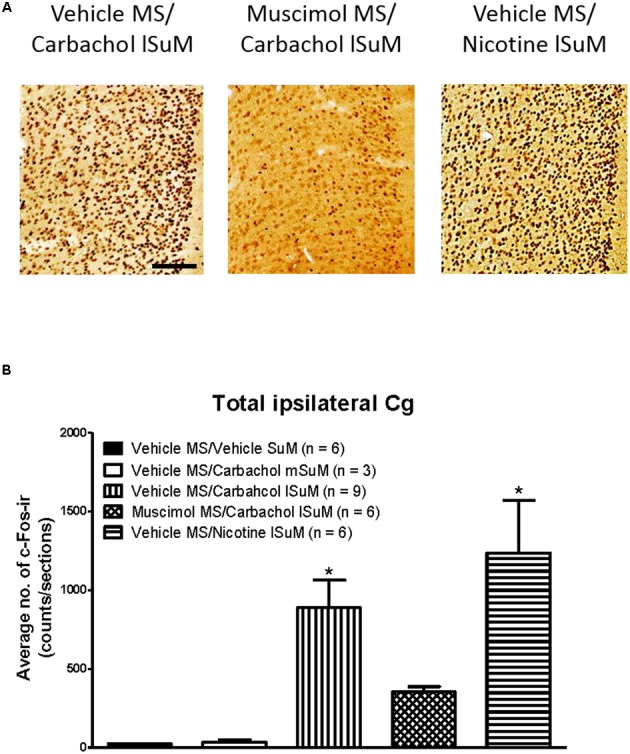
Medial septum modulates lSuM-induced expression of c-Fos-ir in the ipsilateral Cg. (A) Digital images showing c-Fos-ir in coronal sections taken through the Cg (anterior ∼1.80 mm from Bregma). Note the high level of c-Fos-ir in the Cg in Vehicle MS/Carbachol lSuM and Vehicle MS/Nicotine lSuM groups. The level of the label is relatively very low in the Muscimol MS/Carbachol lSuM group. (B) Histogram illustrating changes in the level of c-Fos-ir in ipsilateral Cg on microinjection into MS and SuM. The histograms are built as in Figure 4. Data are mean ± SEM. Significant difference (p < 0.05): ∗ vs. Vehicle MS/Vehicle SuM and Vehicle MS/Carbachol mSuM. Statistical analyses were performed using Kruskal–Wallis statistic followed by Dunn’s Multiple Comparison Test. Scale bar represents 100 μm.